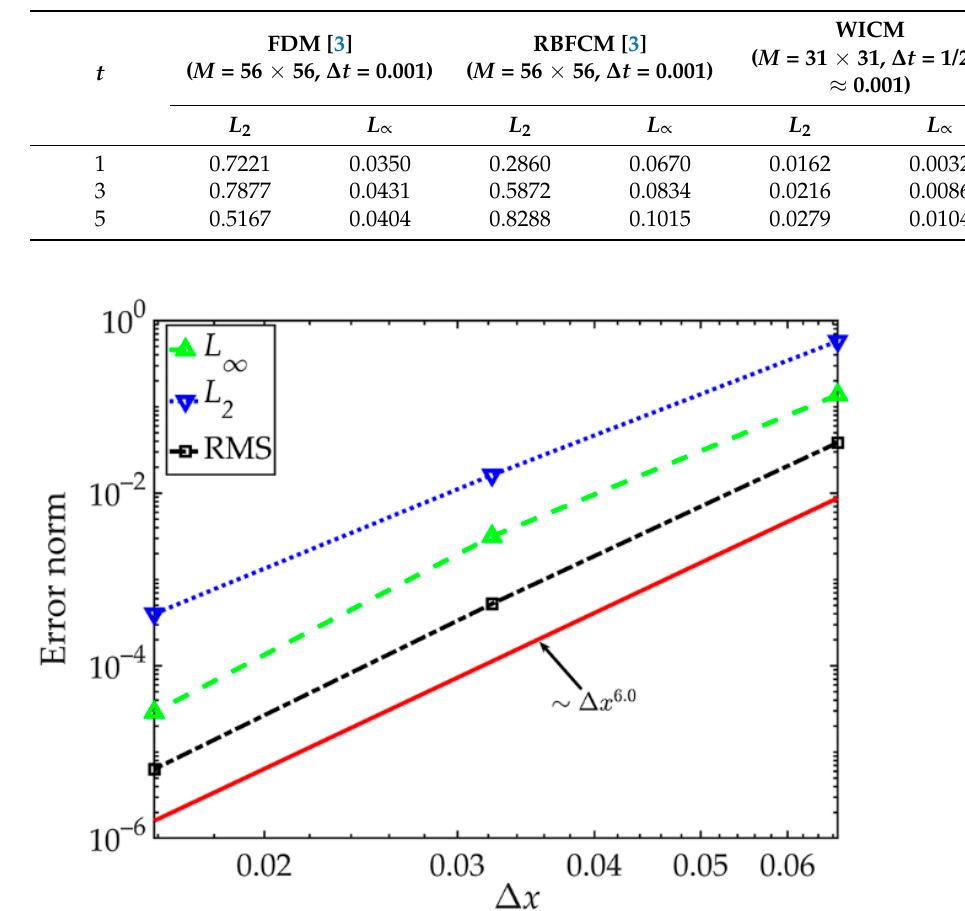
Figure 3. Relation between error norms of the wavelet solution at t = 1 and the spatial mesh size Δ x for Case I of Example